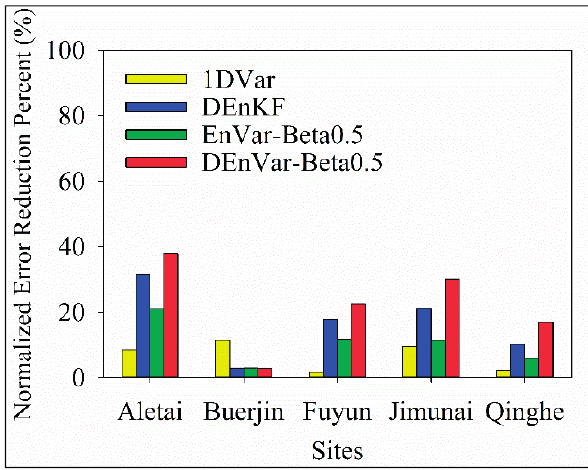
Figure 6. Analysis of SWE state. Cf . Figure 4.